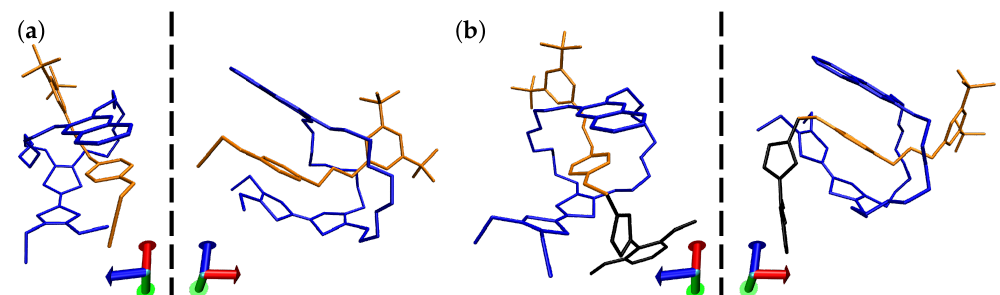
Figure 2. Most stable co-conformations of ( a ) A1@TTFC8 and ( b ) A1 s @TTFC8 , each shown from two perspectives without counterions. The axle, macrocycle, and stoppering unit are depicted in orange, blue, and black, respectively. Hydrogen atoms are omitted for clarity. Axes are added for